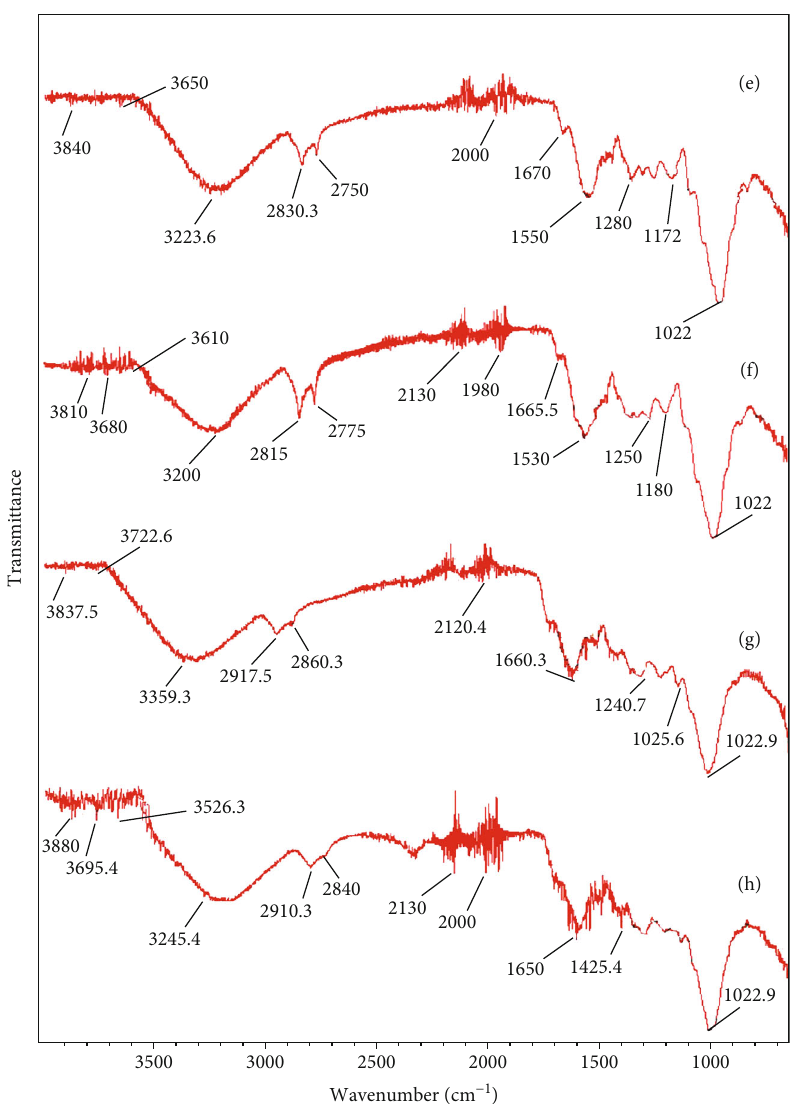
Figure 6: Comparative FTIR analysis after adsorption of CGR on chemically modi fi ed adsorbents ((e) CGR+ PWM, (f) CGR+CPWM, (g) CGR+ PWC, and (h) CGR